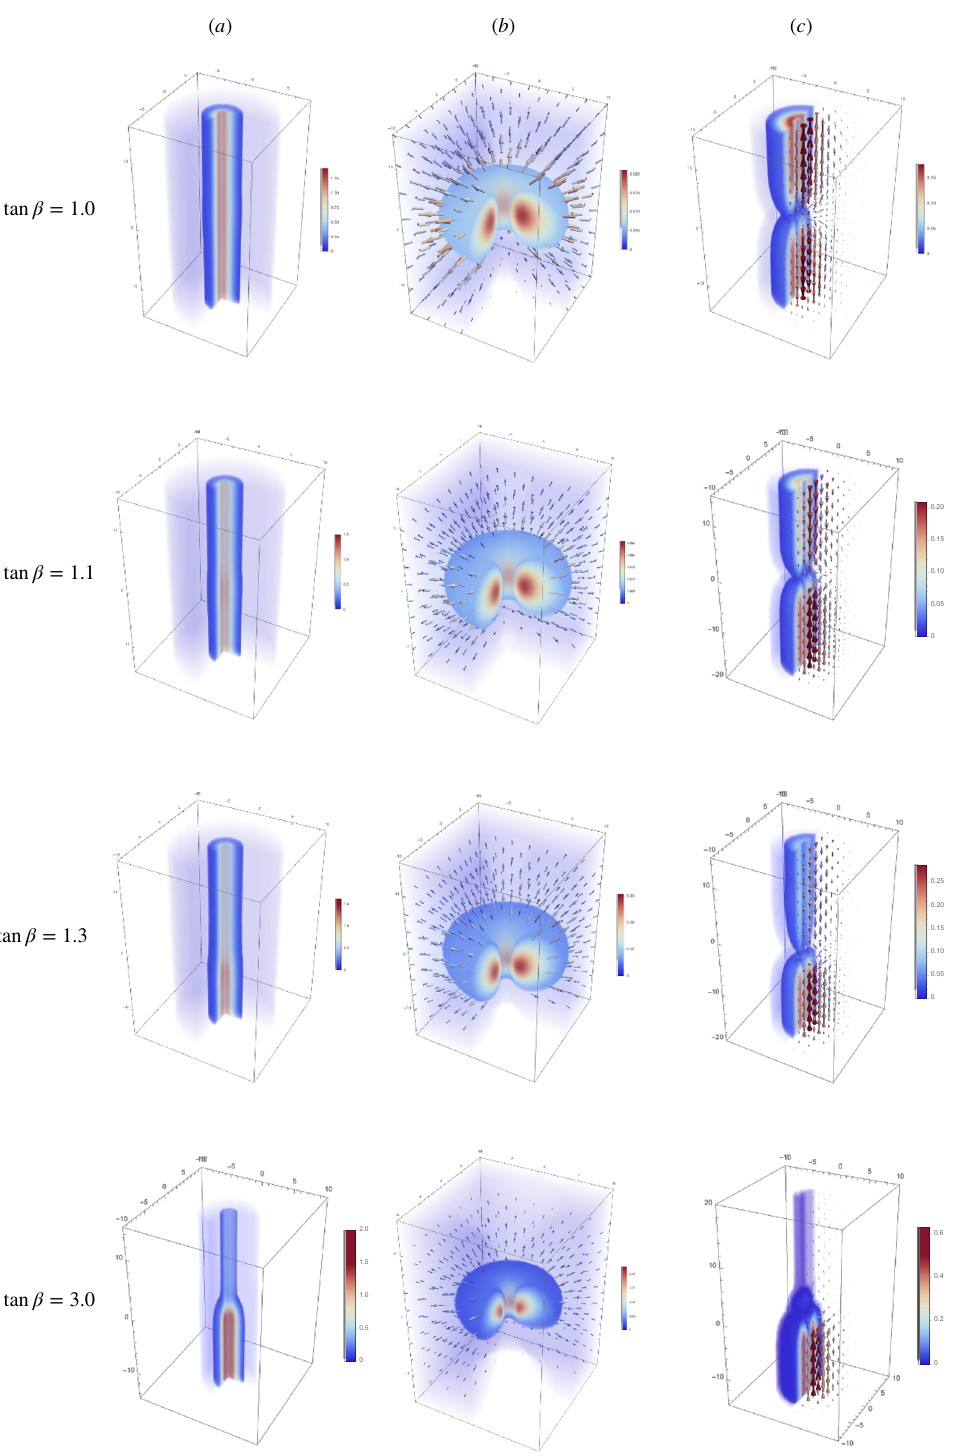
Figure 2 . Plots for the Nambu monopole for the ( Z 2 ) C symmetric and non-symmetric case. The p symmetric case is tan (cid:12) = 1 : 0. In all plots, ( v 2 + v 2 ) = 2 = v EW = 2 is normalized to unity. (a): 1 2 energy density. The color represents its value, where red is the largest and blue is the smallest. (b): magnetic (cid:13)ux. The direction of the arrows indicates that of the (cid:13)ux. Also, the color and size of the arrows indicate the (cid:13)ux density, where red is the strongest, blue is the weakest. (c): Z (cid:13)ux. The direction, color and size of the arrows are the same as those for the magnetic (cid:13)ux.